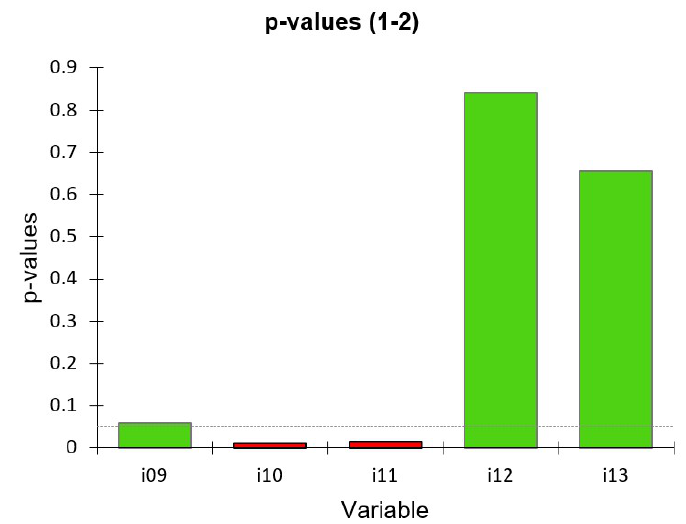
Figure 6. P -values of the Mann–Whitney U test of items concerning the educational design of the program according to whether the descriptor appears generally or specifically.